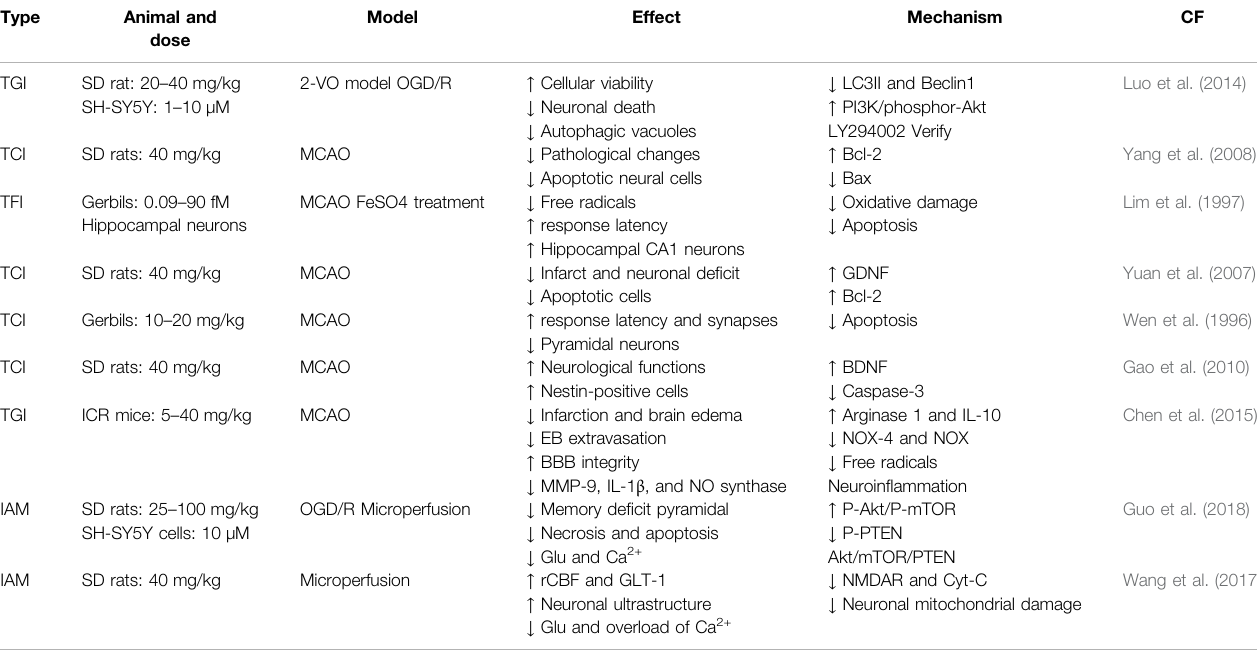
TABLE 1 | Antiapoptotic effects of GRb1 on cerebral I/R injury based on current reports and results. Type Animal and